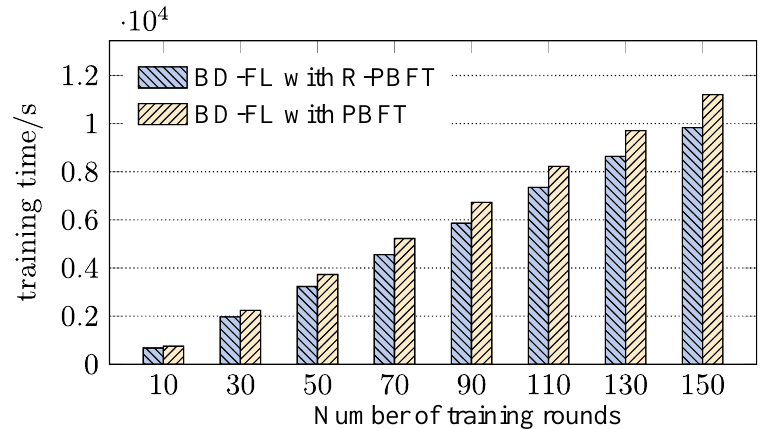
Figure 8. Model training time with different consensus